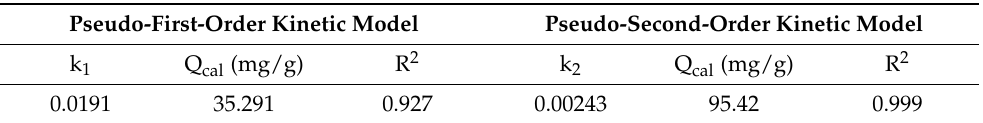
Figure 5. Co@AC adsorption kinetics of atrazine: ( a ) pseudo-first-order kinetic model, ( b ) pseudo- second-order kinetic model. (Co@AC dosage 60 mg/L, atrazine concentration 10 mg/L, the solution pH value 4.0, reaction temperature 25 ◦ C). Table 1. The constants of pseudo-first-order kinetic and pseudo-second-order kinetic models for the adsorption of atrazine on